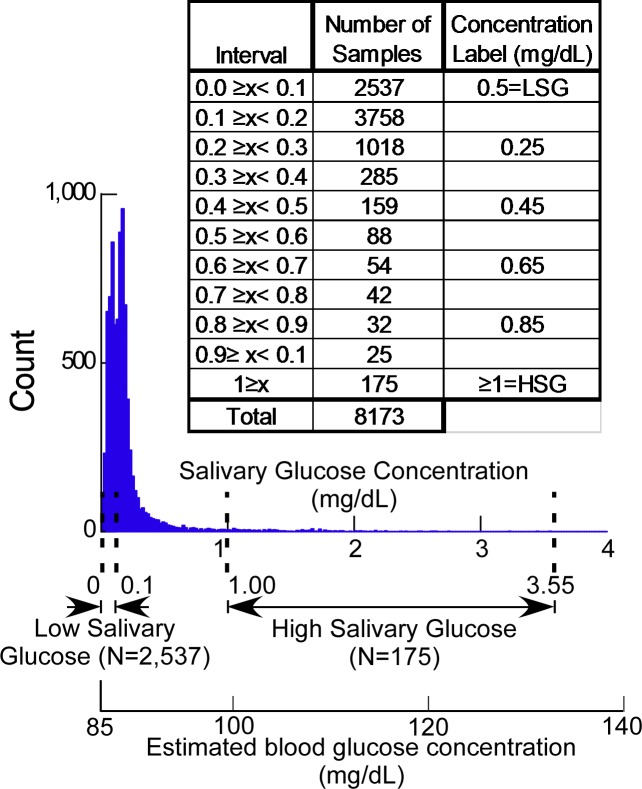
Distribution of salivary glucose levels measured in 10-year old Kuwaiti adolescents.The fasting salivary glucose concentration of 97.8% of samples assayed was below 1 mg/dL (normal healthy range). Fasting salivary glucose concentrations above 1 mg/dL correlate with plasma glucose concentrations ≥100 mg/dL. The inset table defines intervals and number of samples used for median value computation (x = salivary glucose concentration). High salivary glucose (HSG) intervals, low salivary glucose (LSG) intervals, and estimated blood concentration (for plasma concentrations ≥ 84.8 mg/dL, Plasma = 13.5*Saliva+84.8 [24]) are illustrated.